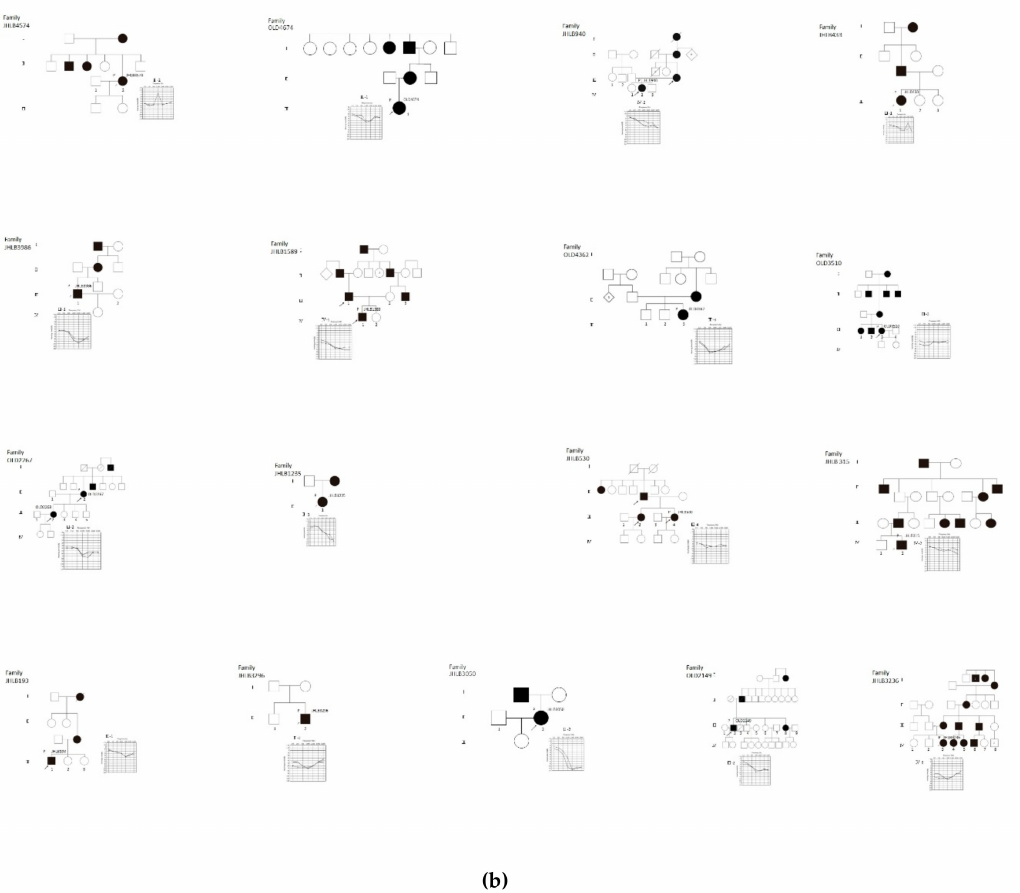
Figure 1. Pedigrees and audiograms of patients with MYO6 -associated hearing loss. Arrowheads indicate family members receiving genetic testing, and arrowheads accompanying a “P” indicate the probands. ( a ) Filled symbols indicate a ff ected individuals, and open symbols indicate una ff ected individuals. ( b ) Pedigrees and audiograms of patients with MYO6 -associated hearing